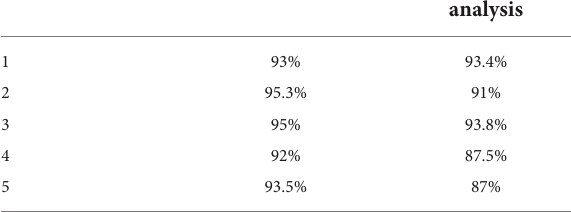
TABLE 4 Analysis of product satisfaction based on human-computer interaction